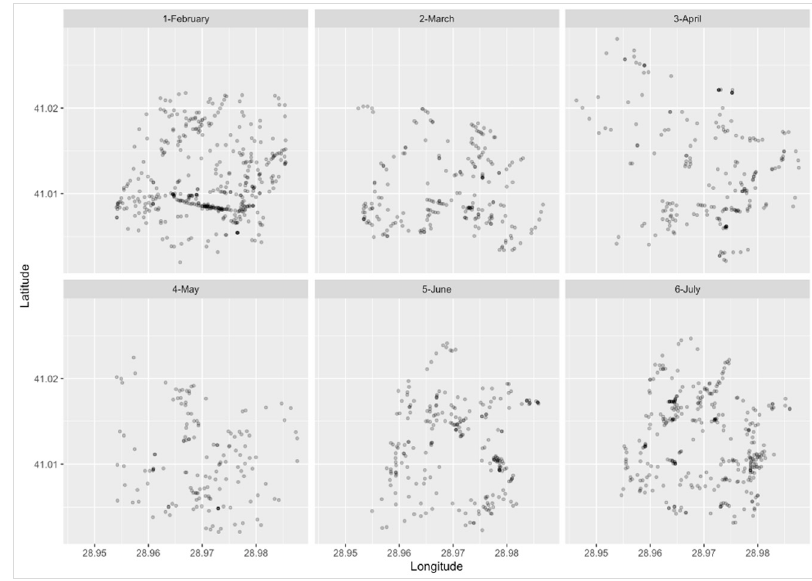
Figure 1. Cartesian coordinate system of the address queries by month.